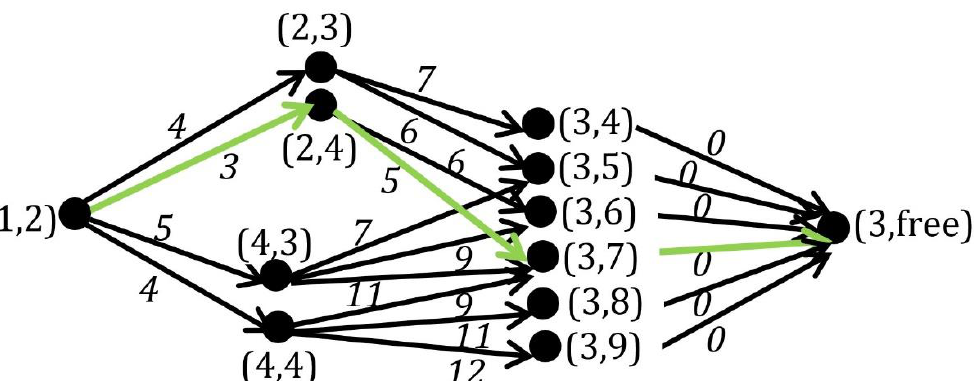
Figure 4. Weighted ESTEN graph for fuel objective, with minimum fuel consumption space-time route highlighted